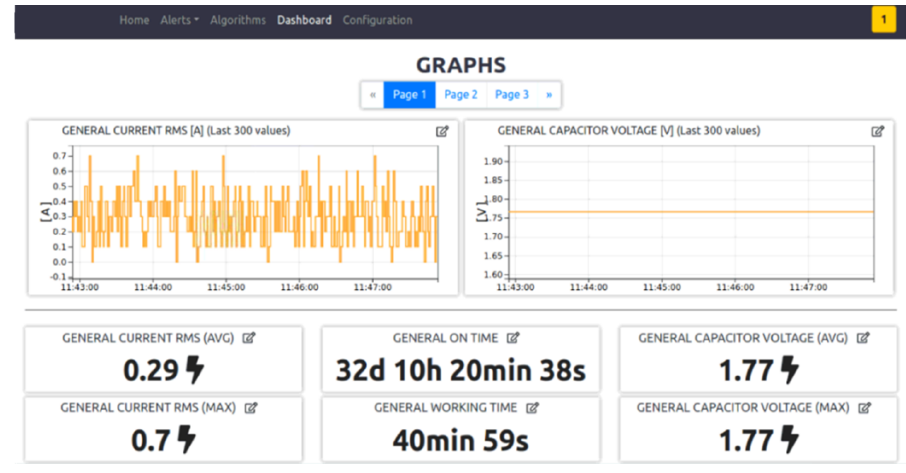
Sensors 2021 , 21 , x FOR PEER REVIEW Figure 8. Vehicle dashboard page. Figure 8. Vehicle dashboard page.